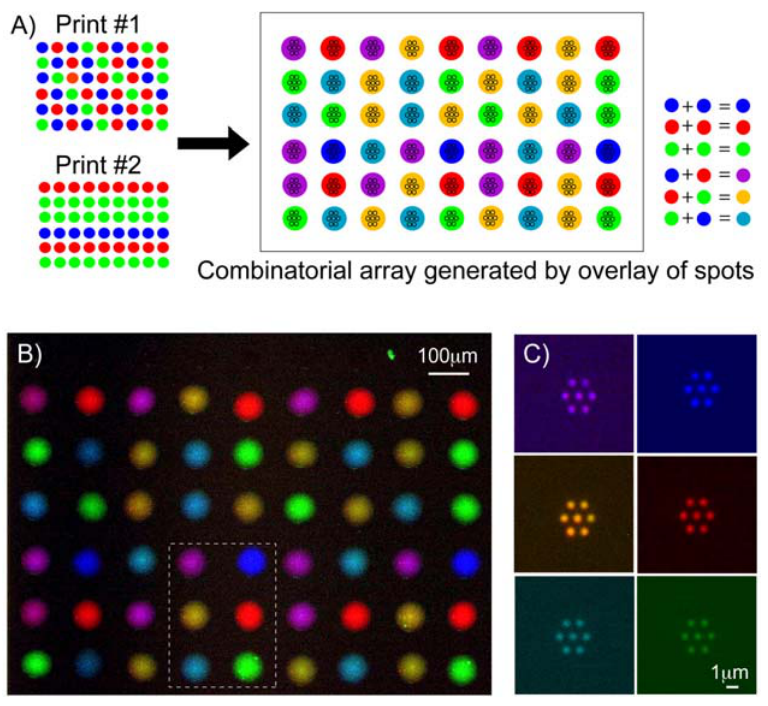
Figure 6. The PNP process can generate combinatorial biomolecular nanoarrays. (a) Schematic diagram showing the process of superimposing a second inkjet print-run immediately over the first print to generate six different combinations of antibodies from an initial pool of three separate antibodies. (b) Pseudo-colour merged fluorescence image showing the combinatorial array that can be inkjet printed onto the parylene template. (c) Antibodies nanoarrays of six different biomolecular combinations were generated after parylene peel-off, corresponding to the spots demarcated within the boxed region in (b). Reproduced with permission from reference [7]. Copyright 2010 American Chemical